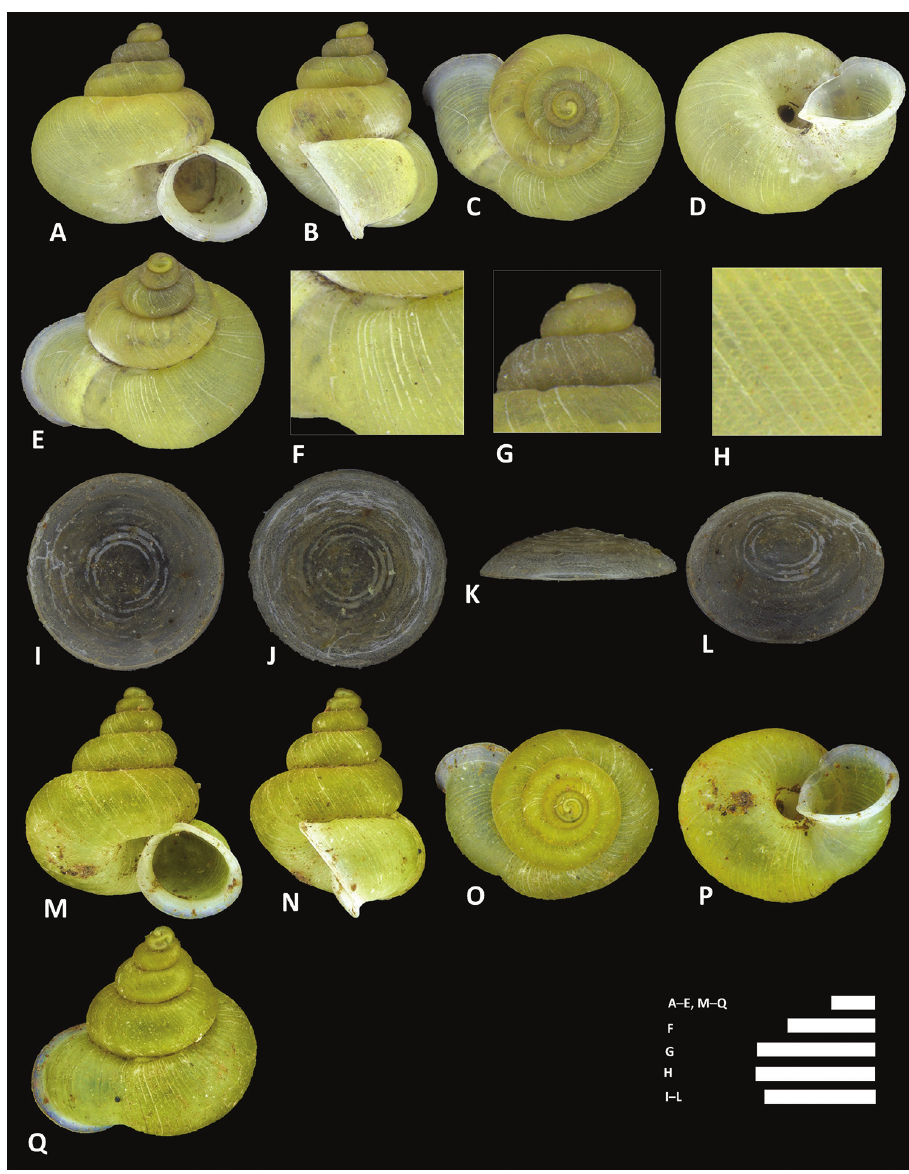
Figure 8. Alycaeus alticola sp. n. A–E Shell of holotype, BOR/MOL 8398 F–H Close up of shell of holo- type, BOR/MOL 8398 I–L Operculum of paratype, BOR/MOL 8398 M–Q Shell of paratype, BOR/ MOL 8398. Scale bars: A–G, I–Q 1 mm; H 0.5 mm. All photographs by Junn Kitt Foon. Spire. Spire height: 1.64–2.23 mm. Spire width: 2.32–2.71 mm. Number of whorls: up to 5. Spire shape: oblong conical. Whorl periphery rounded. Umbilicus open. Whorl constriction. At about 4 ¾ whorls posterior of